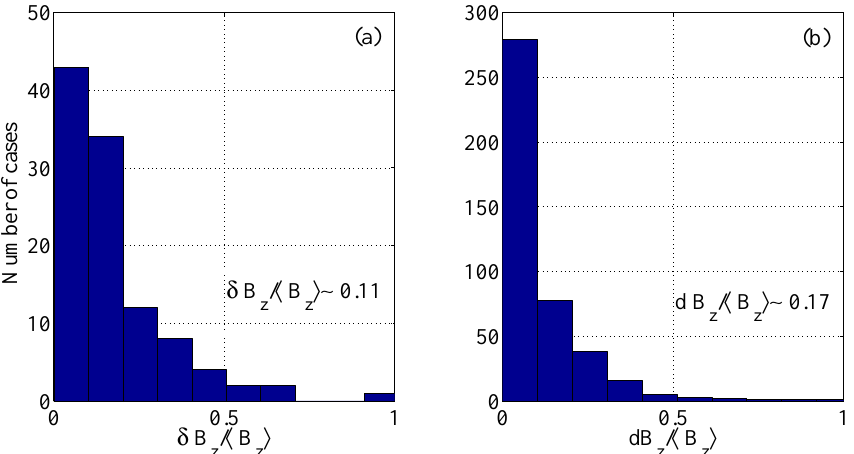
Figure 3. (a) Ratio of standard deviation δB z and magnetic field amplitude (cid:104) B z (cid:105) averaged for different CS crossings within each series. (b) Ratio of standard deviation d B z and magnetic field amplitude (cid:104) B z (cid:105) averaged for each CS